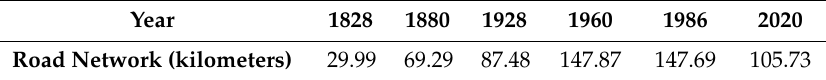
Table 1. The length of the highest category of road